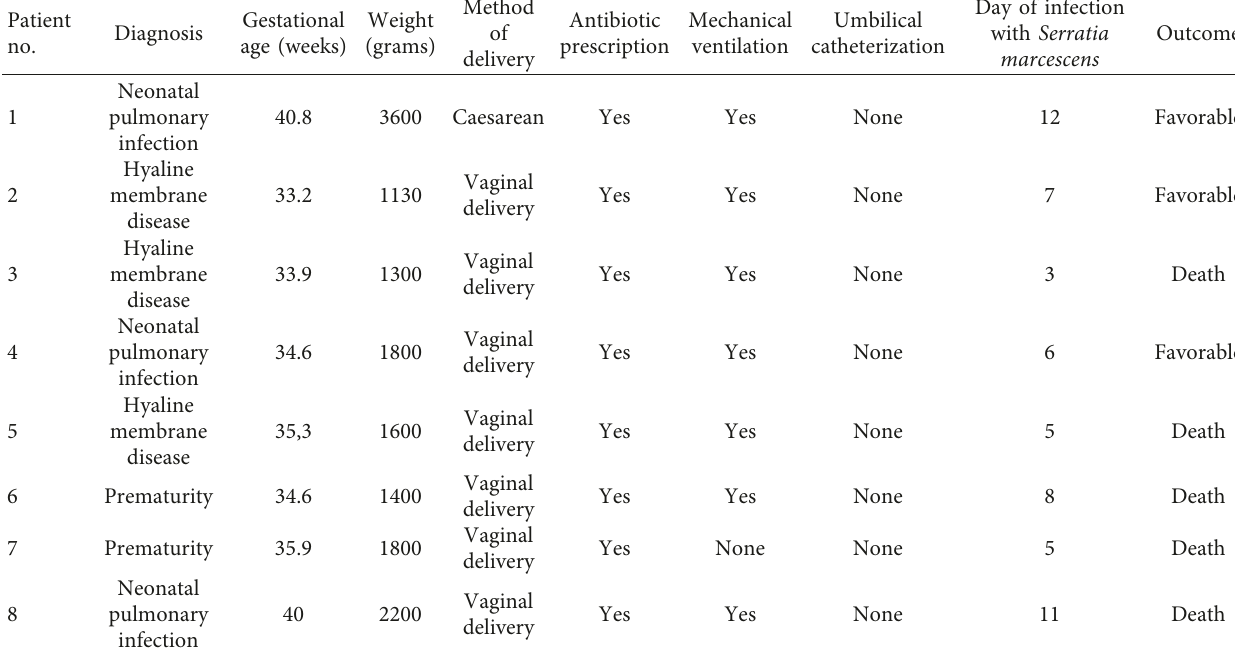
Table 1: Patients’ demographic